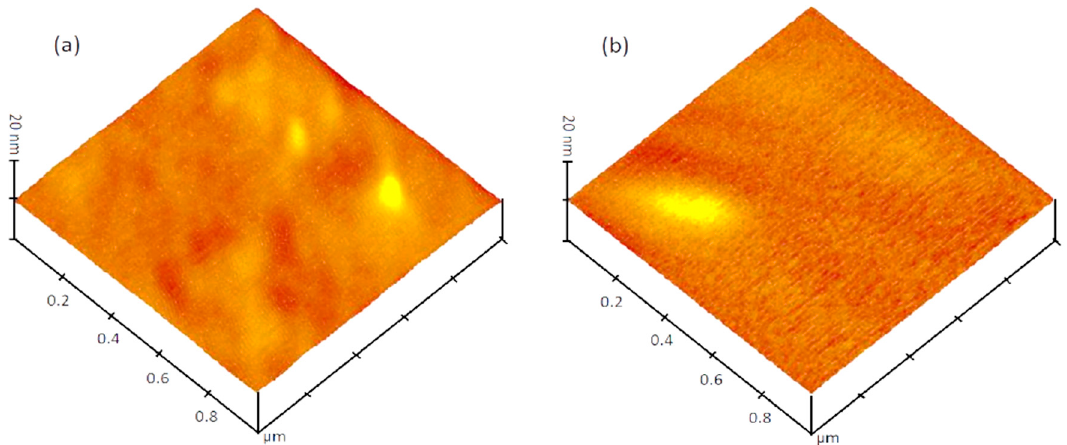
Figure 3. ( a ) Surface morphology of TiON-0.5 with a surface roughness (RMS) of 0.7 ± 0.1 nm. ( b ) Surface morphology of TiON-2 with a surface roughness (RMS) of 0.2 ± 0.1 nm.